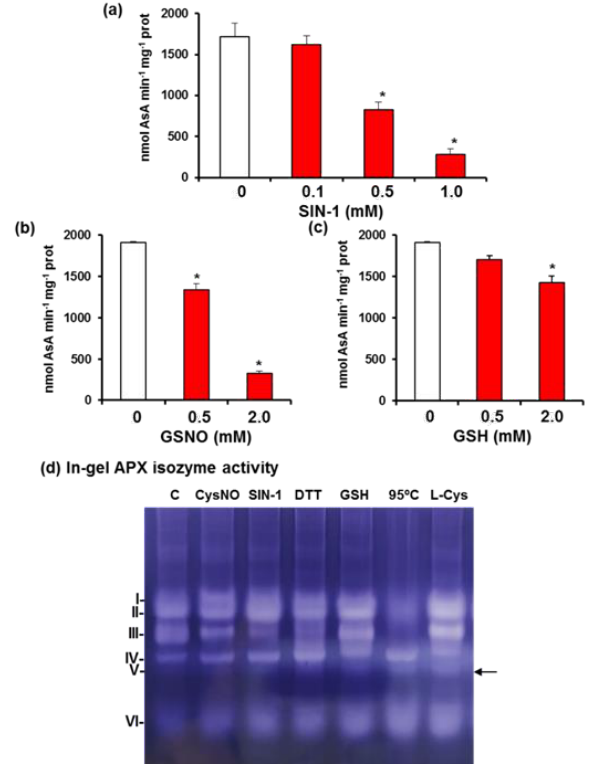
Figure 6. Effect of nitration, S -nitrosation and reducing agents on isoenzymatic ascorbate peroxidase (APX) activity in green pepper fruits. ( a ) Effect of SIN-1 (peroxynitrite donor). ( b ) Effect of S -nitrosoglutathione (GSNO). ( c ) Effect of reduced glutathione (GSH). ( d ) In-gel isozyme profile of APX activity assay under different treatments including 5 mM nitrosocysteine (CysNO, a NO donor), 5 mM SIN-1, 5 mM DTT, 95 °C for 5 min, and 5 mM L-cysteine (L-Cys). Protein samples (30 µg per lane) were separated by non-denaturing polyacrylamide gel electrophoresis (PAGE; 10% acrylamide), and activity was detected by the nitro blue tetrazolium (NBT)-reducing method. APX isozymes were labeled I – VI (on the left) according to their increasing electrophoretic mobility. Spectrophotometric APX activity data represent the mean + SEM of at least three independent biological replicates. Asterisks (*) indicate significant differences ( p < 0.05) in comparison to the control. Arrow